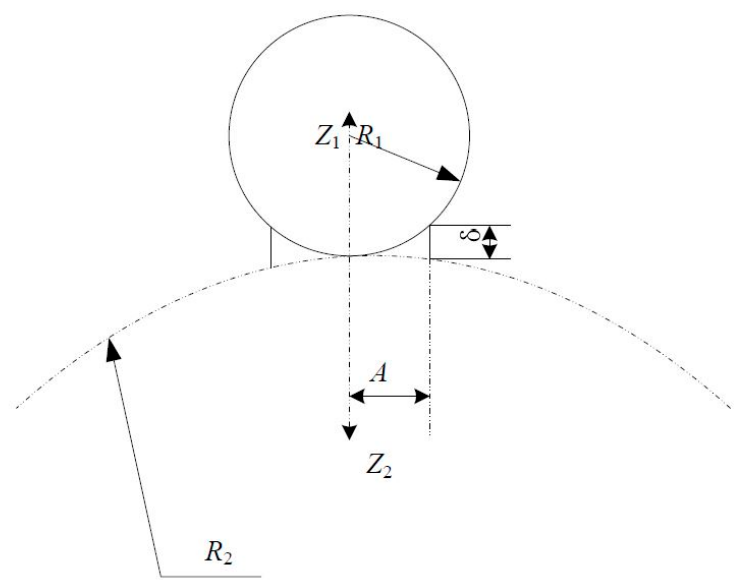
Figure 8. Hertz contact element [16].